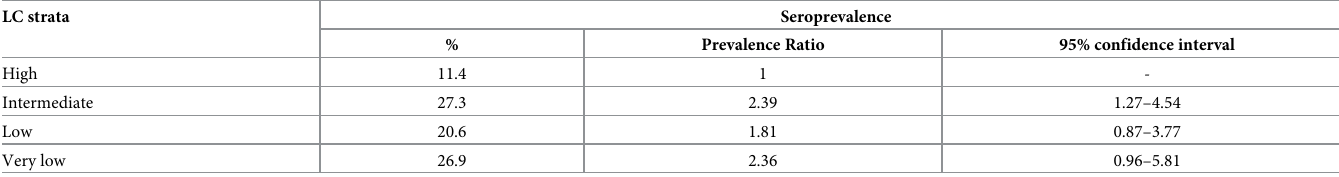
Table 3. Seroprevalence and seroprevalence ratio of chikungunya by Living Condition (LC) strata. Feira Santana–Bahia, April to September, 2017. LC